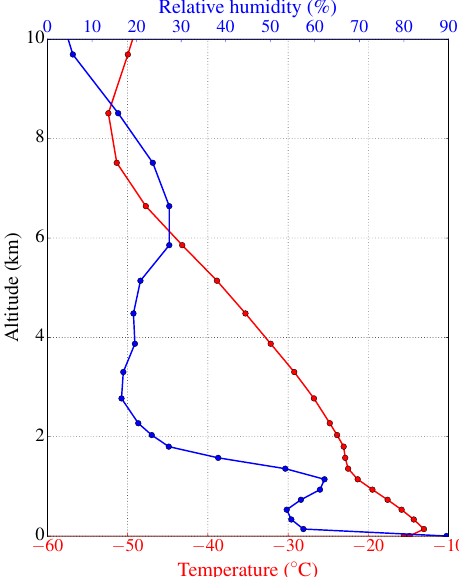
Figure 10. FIRR setup for ground operation at INO facilities on 21 February 2015. Figure 11. ERA-Interim profiles of temperature and humidity on 21 February 2015, 00:00UTC. For the sake of clarity, the profile is shown up to 10km only, but the reanalysis used for the radiative transfer calculations actually extends up to